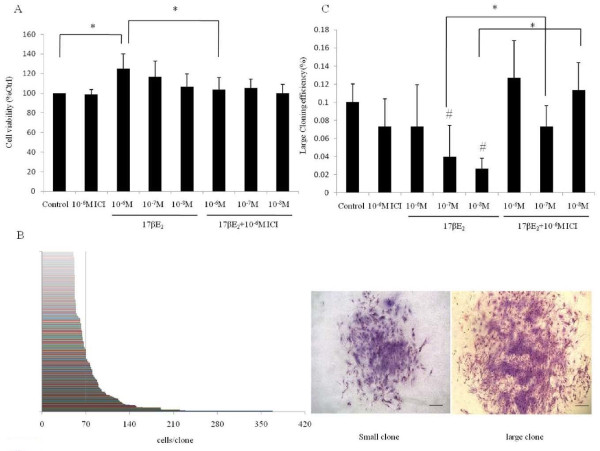
Effect of 17β-E2 on the proliferation and formation of large cloning efficiency of SP cells. Percentage and large cloning efficiency of SP cells treated with 17β-E2 and 17β-E2 +ICI182780 (Faslodex, inhibitor of ESR1) for 24 h. Figure 4A. SP cells were pretreated with 17β-E2 and 17β-E2 +ICI182780 at different concentration (10-8 to10-6M) for 24 h, after which the cell viability was estimated by the MTT assay. n = 4 experiments. * Compared with control, p < 0.05. Figure 4B. Distribution of colony size of SP cells cultured in phenol red-free sera medium for 15 days. The number of cells per colony from 344 colonies was counted, with the data generated used to discriminate small and large colonies, as shown by the vertical line at 70 cells. Hematoxylin staining of small clone (left) and large clone (right). Scale bar, 100 μm. Figure 4C. Large cloning efficiency of SP cells treated with 17β-E2 and 17β-E2 +ICI182780 at different concentration (10-8 to10-6M) for 15 days. #Compared to control, and *P < 0.05.